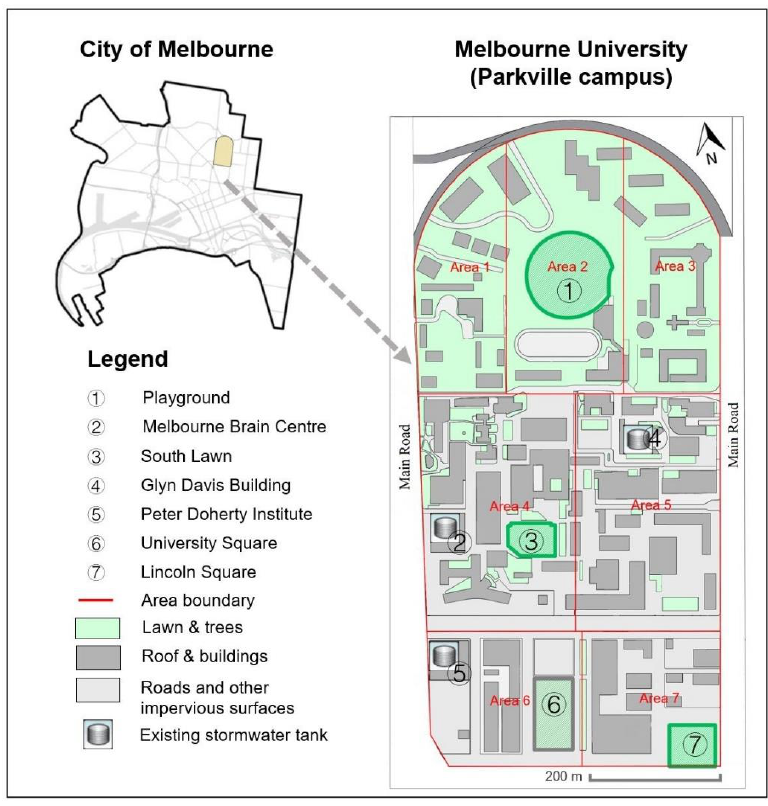
Figure 1. The study area (Parkville campus of Melbourne University).